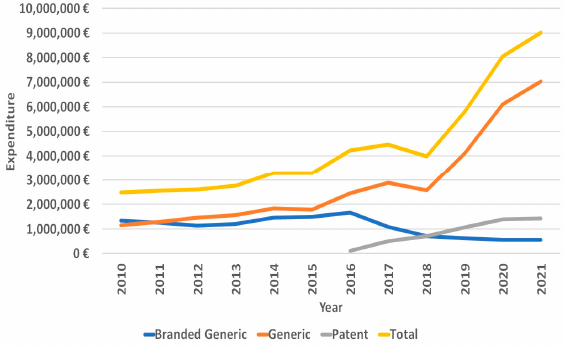
Figure 7. Expenditure on statins.